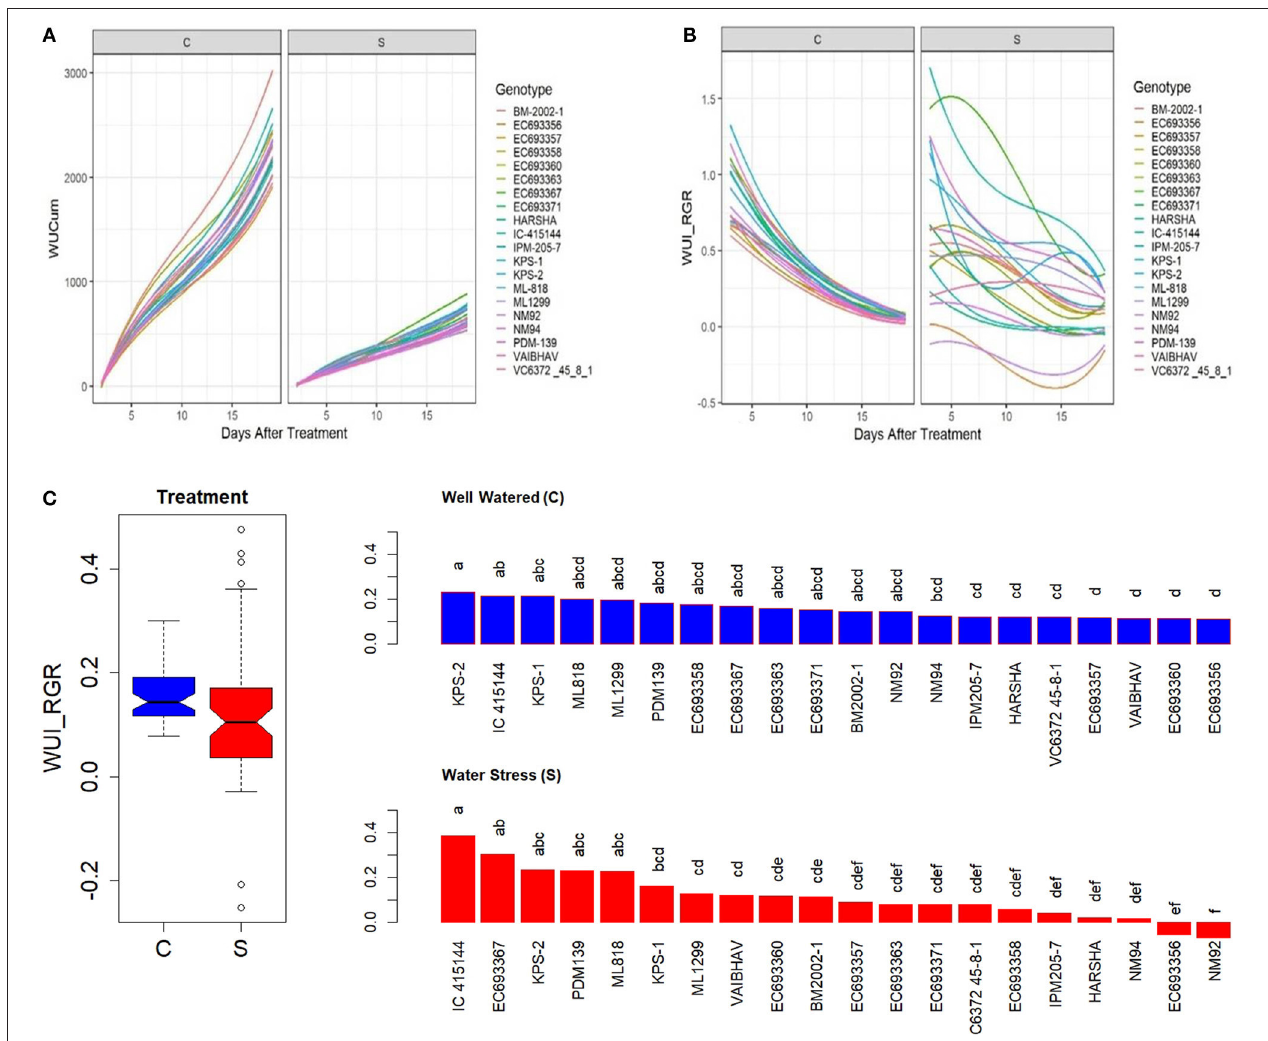
FIGURE 8 | Genetic variation in (A) cumulative water use (WUCum, ml plant − 1 ), (B) WUI_RGR derived from RGR as in Material and Methods, and (C) genetic variation in WUI_RGR of mungbean genotypes under well-watered (C) and water-stressed (S) conditions. In (C) , the values for each box in the treatment effect represent 60 observations (3 replications and 20 genotypes), and each bar in the genotype effect for each treatment represents mean values of three replications. Letters represent the significance of differences among mean values as computed by the Duncan multiple range test at 0.95 CI. Genotypes with common letters are not significantly